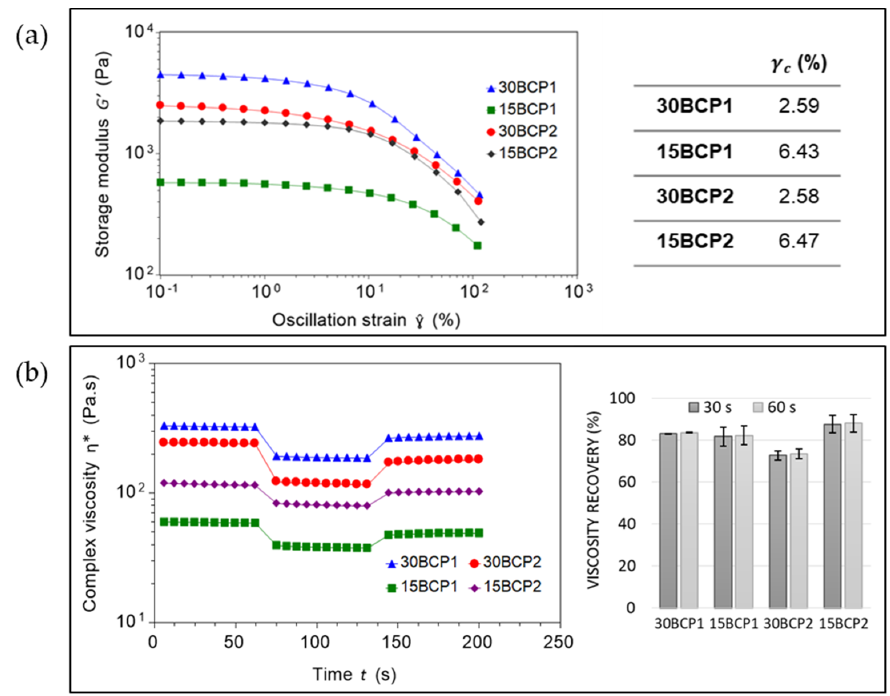
Figure 4. ( a ) LVR and critical strain ( 𝛾 (cid:3030) ) of the inks. ( b ) Stepped Dynamic Method (SDM) and vis- cosity recovery (%) at room temperature. viscosity recovery (%) at room